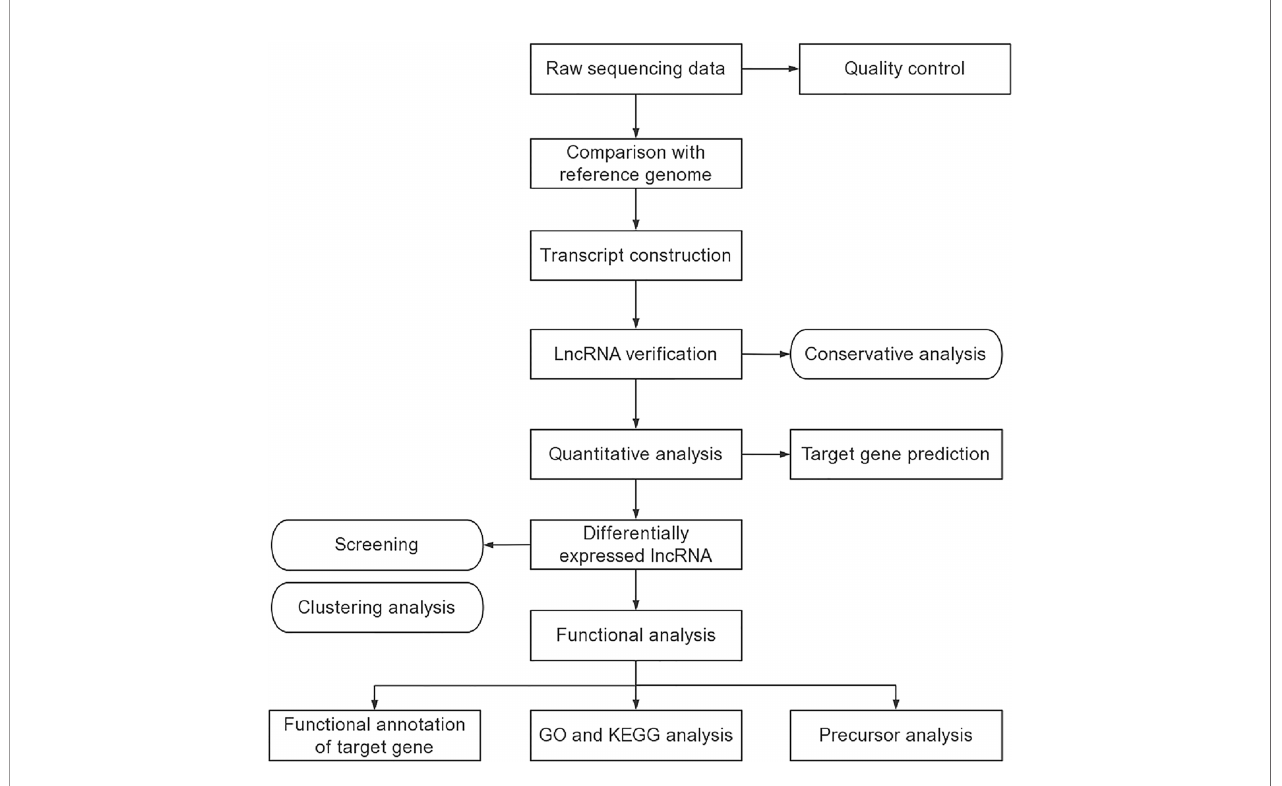
FIGURE 2 | The procedures of exosomal lncRNA sequencing and bioinformatics